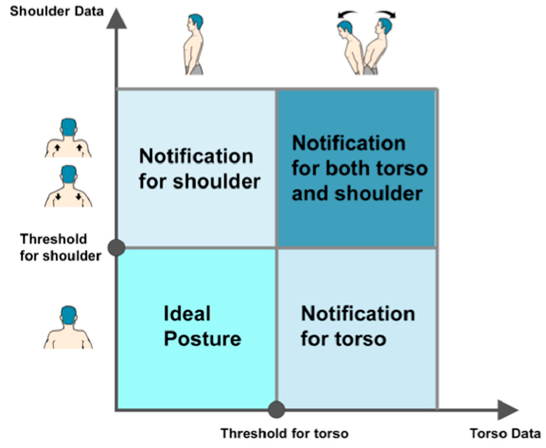
Figure 7. Feedback strategy.